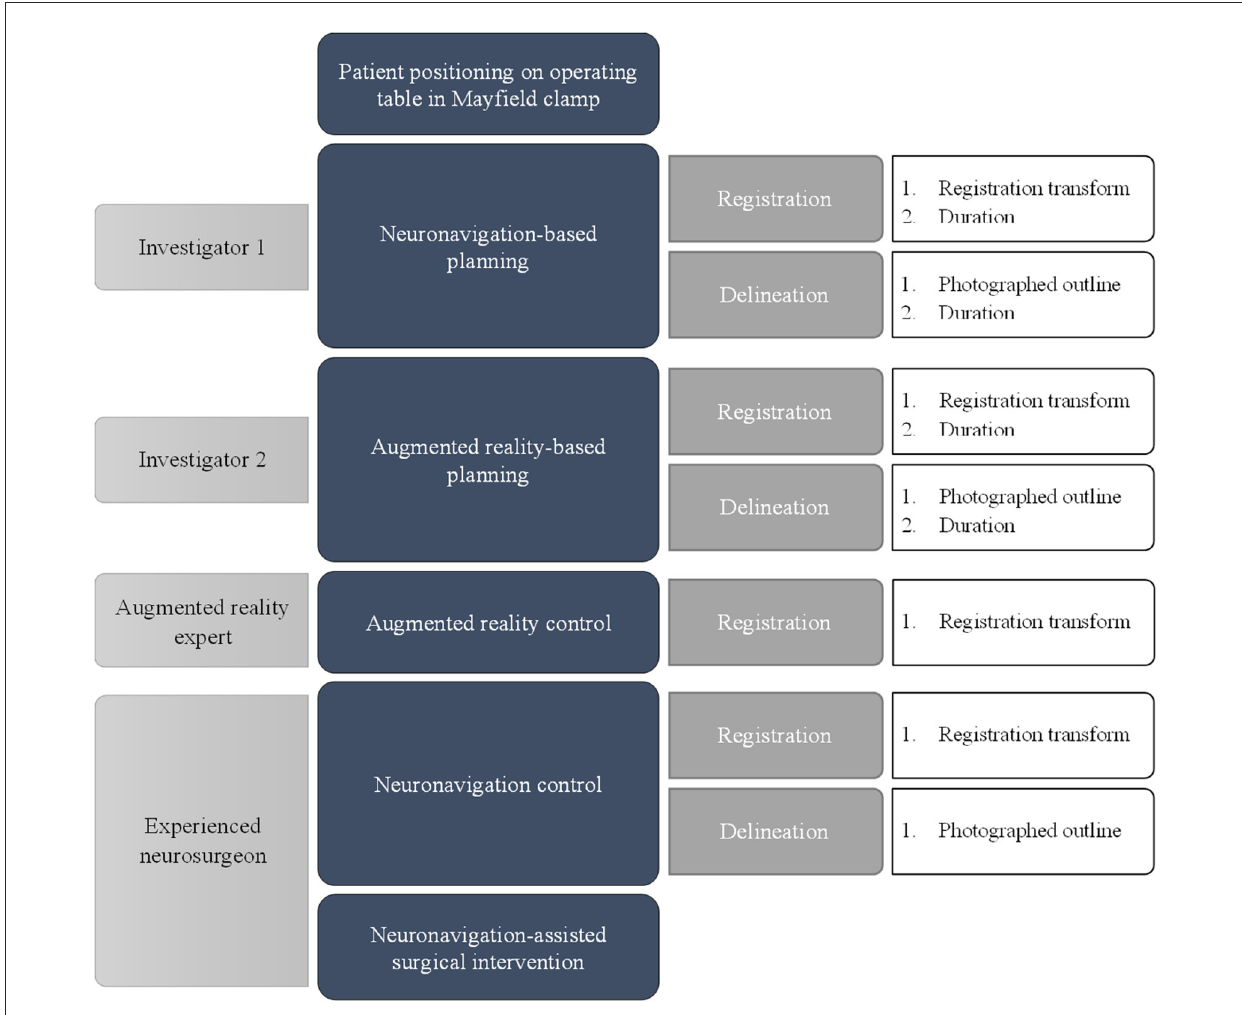
FIGURE5 Flow diagram of the different experimental phases for a single